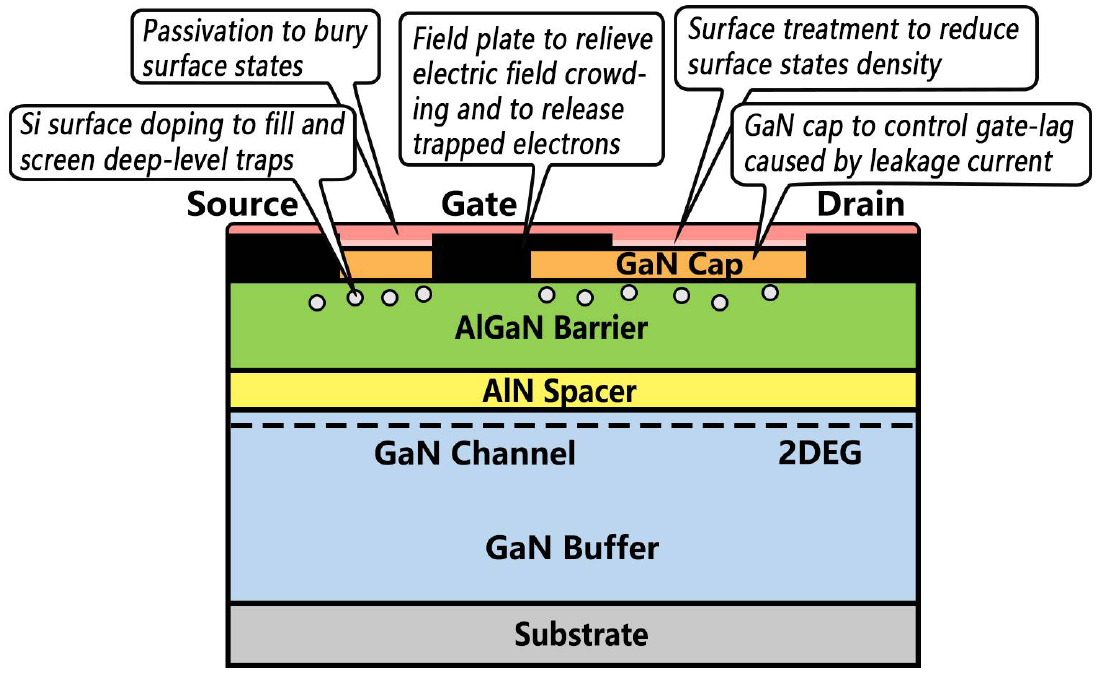
Figure 3. Common methods for suppressing RF dispersion in AlGaN/GaN HEMTs.